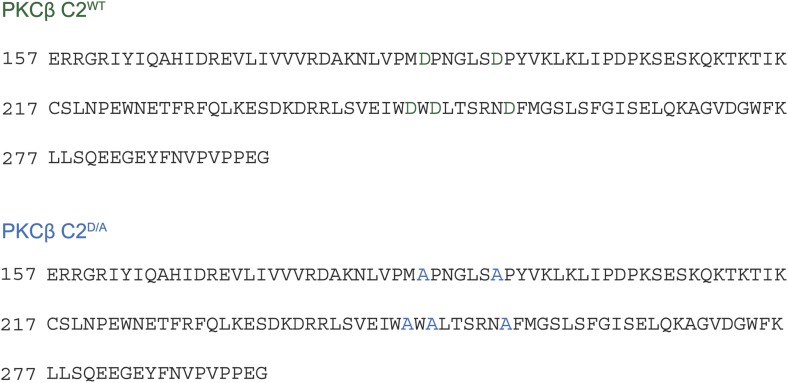
Protein sequence alignment for PKCβ C2WT and PKCβ C2D/A.